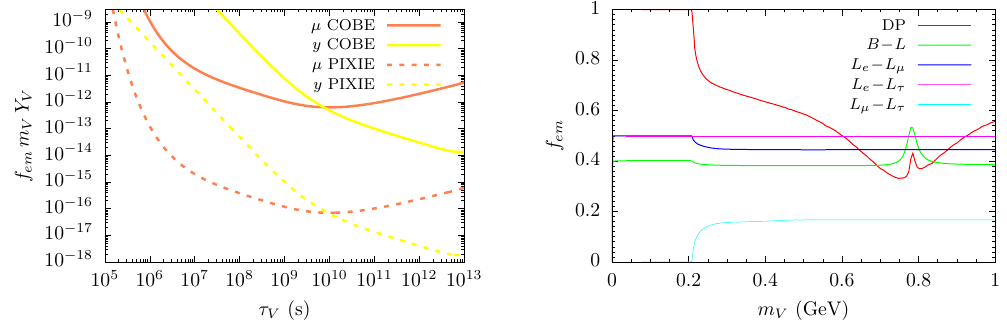
Figure 5 . In the left panel we show current (projected) bounds from COBE/FIRAS (PIXIE) on the electromagnetic decay factor f em m V Y V from late-time vector decays as a function of the decay lifetime (cid:28) V . The right panel shows the electromagnetc decay fraction f em for the (cid:12)ve dark vector theories studied in this